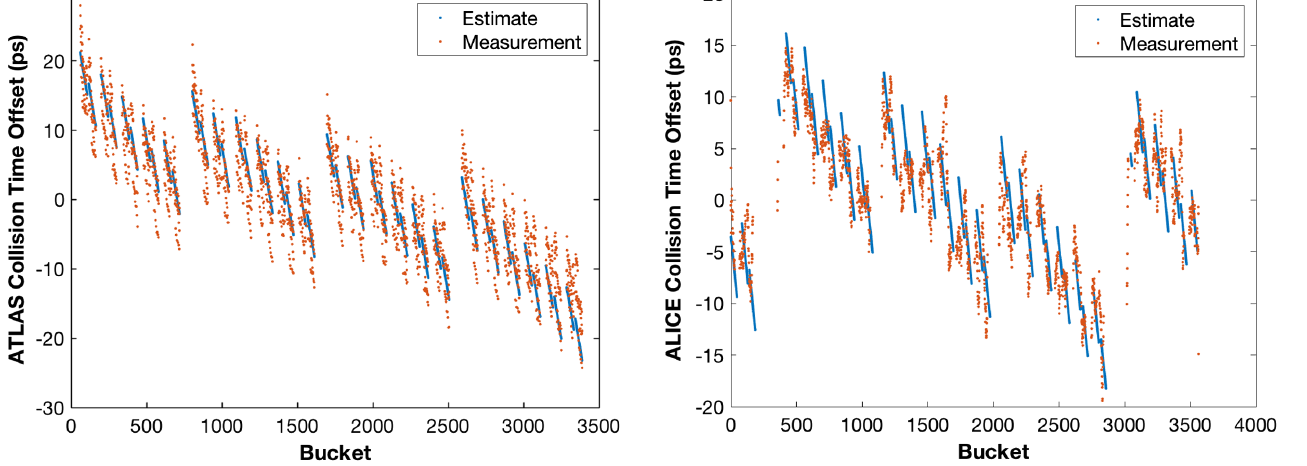
FIG. 22. Collision point time shift for the ATLAS